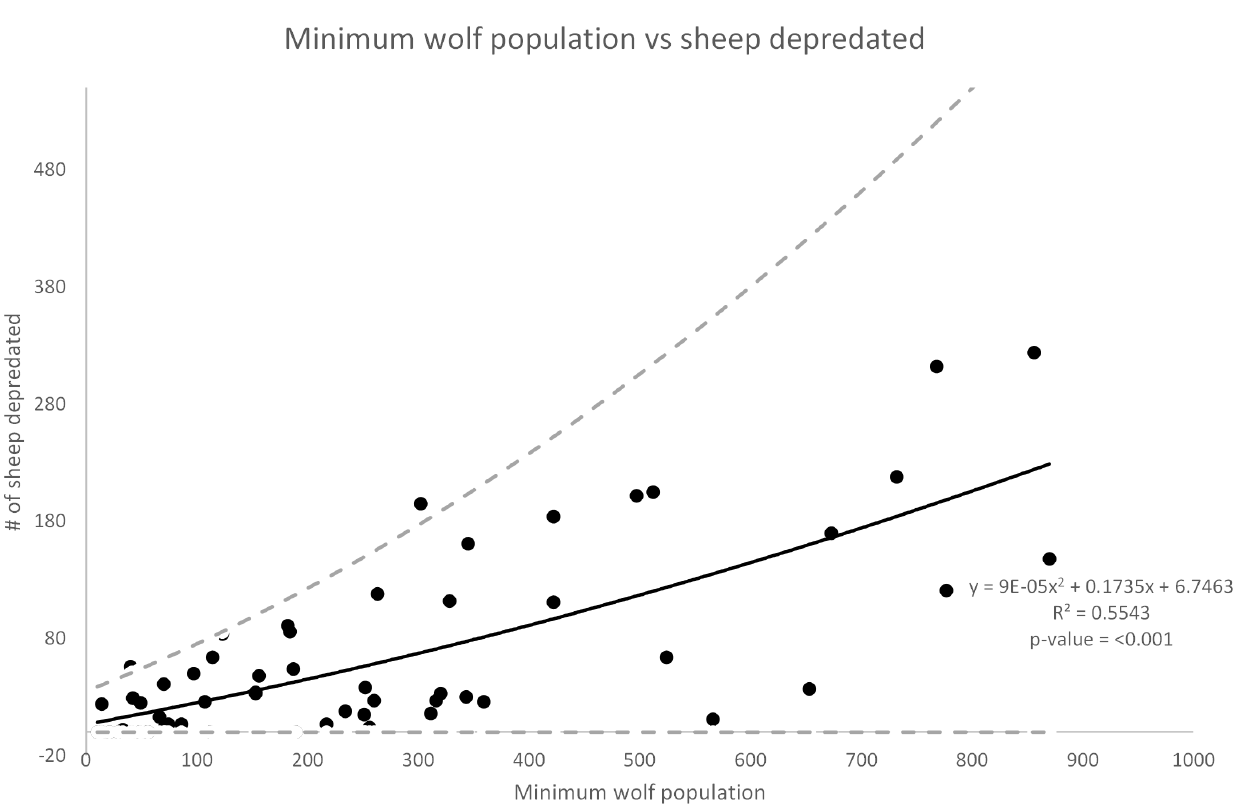
Figure 5. Minimum wolf population vs sheep depredated. Minimum year end wolf population the previous year versus the number of sheep depredated the following year. The dashed lines show the upper and lower limits of the 95% confidence interval for the best fit